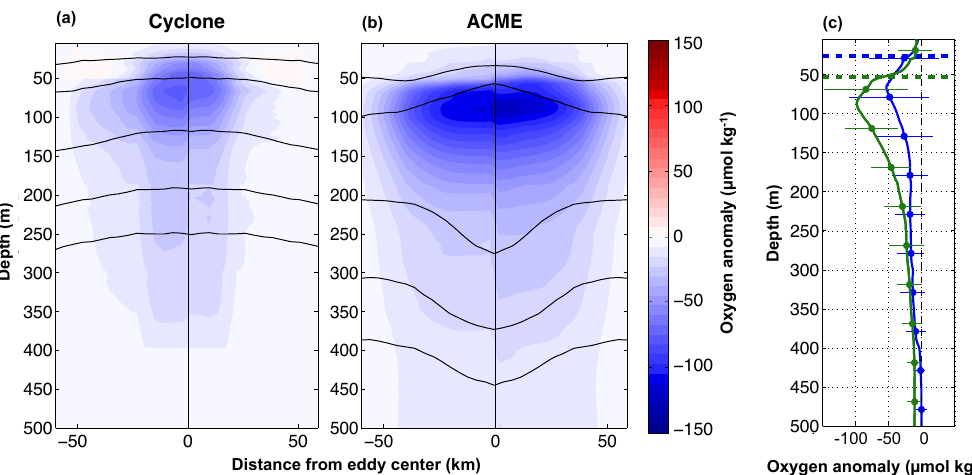
Figure 8. Vertical structure of oxygen from the composite (a) CE and (b) ACME in the ETNA presented as a half section across the eddies. The left side of both panels ( − 60 to 0km) is based on reconstructed and measured oxygen profiles whereas the right side (0 to 60km) is based on measured oxygen profiles only. Both methods are shown against the normalized radial distance. The blackb lines represents the density surfaces inside the eddies. (c) Mean profiles of the oxygen anomalies based on measured profiles only; green lines are associated with ACMEs and blue to CEs. Horizontal lines indicate the standard deviation of the oxygen anomaly at selected depths. The thick dashed lines indicates the mean ML within the different eddy types. The grey vertical dashed line represents zero oxygen